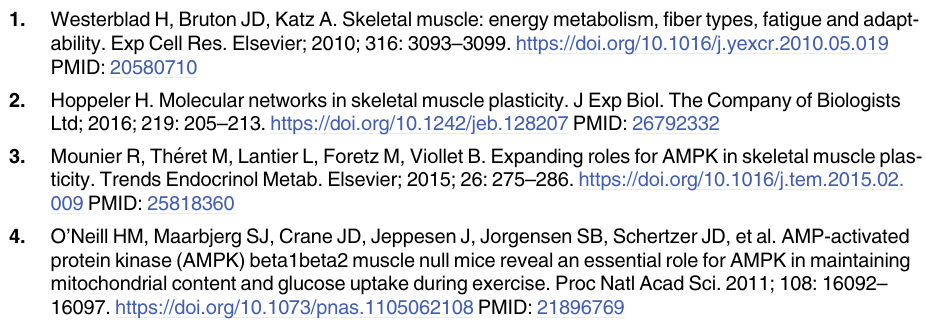
S4 Fig. Phospho-AMPK in the 48 Non-ADP-dominant models. Model-predicted time courses of AMP-p-AMPK and ADP-p-AMPK in the 48 models remaining after the elimina- tion process (see Fig 4 of the main text). The blue, green, and black lines represent the levels of AMP-p-AMPK, ADP-p-AMPK and total AMPK, respectively. The inset numbers represent the corresponding fraction of ADP